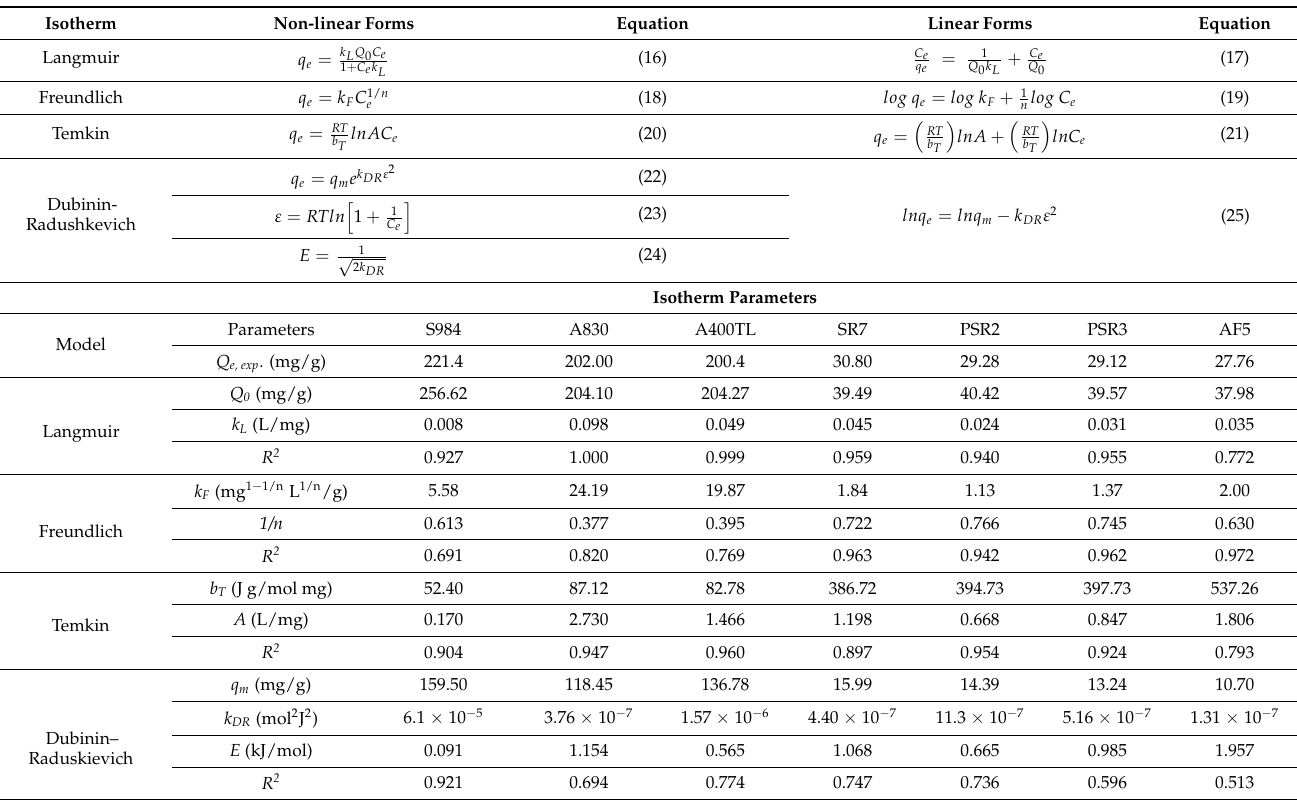
Table 5. Characterization of the isotherm models and the parameters obtained for the V(V) ions sorption on the S984, A830, A400TL, SR7, PSR2, PSR3, and AF5 sorbents. Equation Linear Forms